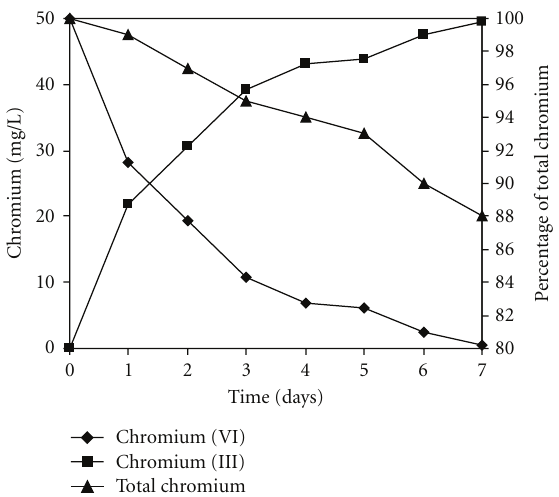
Figure 6: Time-course of Cr (VI) decrease and Cr (III) production in the spent medium of culture initiated in Lee’s minimal medium, amended with 50 mg/LCr(VI). 100 rpm, 28 ◦ C, pH 4.0.